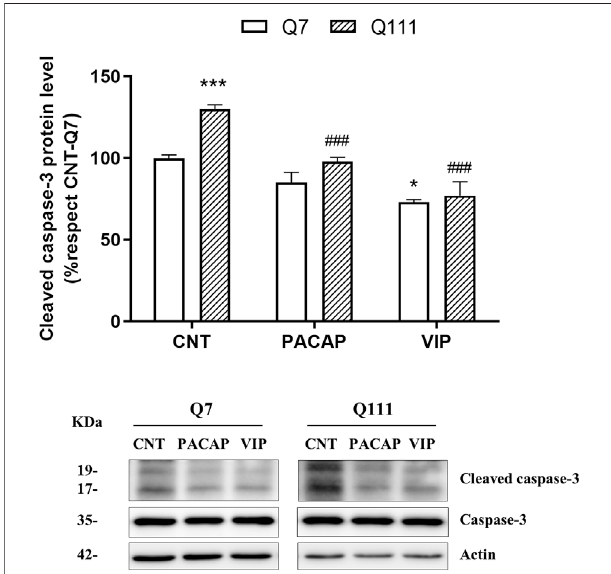
FIGURE 4 | PACAP and VIP reduce apoptosis in STHdhQ111/Q111 cells. STHdhQ7/Q7 (Q7) and STHdhQ111/Q111 (Q111) cells were treated with PBS (CNT), PACAP (10 − 7 M) or VIP (10 − 7 M) for 24 h in a serum free media. Then, cleaved caspase-3 protein levels were measured by Western blot. As no changes were detected in caspase-3 levels between groups, results (mean ± SEM; n (cid:1) 4) were normalized to the loading control actin and are expressed as a percentage respect to CNT-Q7 cells. Representative immunoblots are shown. Data were analyzed by using two- way ANOVA followed by Tukey as a post-hoc test. * p < 0.05 and *** p < 0.001 as compared to CNT-Q7 cells and ### p < 0.001 as compared to CNT- Q111